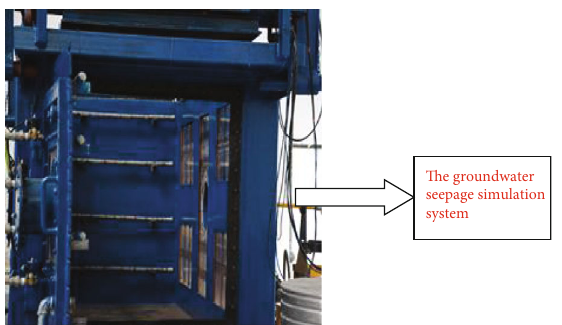
Figure 4: The groundwater seepage simulation system [42].